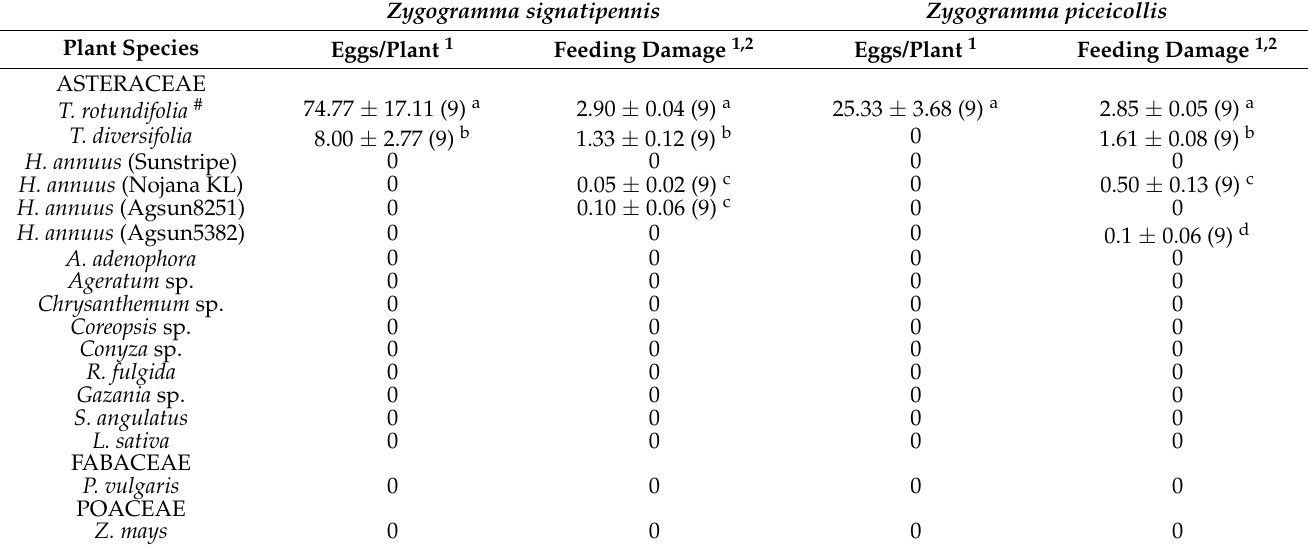
Table 6. Mean ± SE (n) oviposition and feeding damage of Zygogramma signatipennis and Z. piceicollis on various plant species during the multi-choice tests. Zygogramma signatipennis Zygogramma piceicollis Plant Species Eggs/Plant 1 Feeding Damage 1,2 Eggs/Plant 1 Feeding Damage